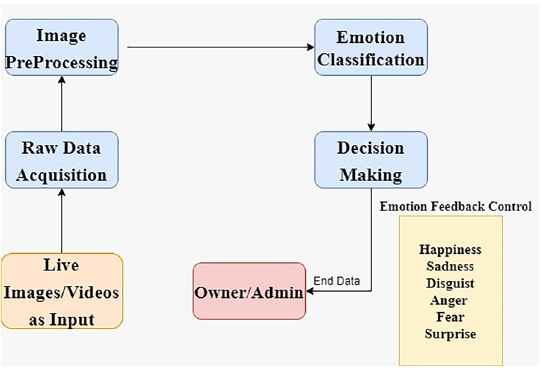
Fig. 4. Proposed System Architecture